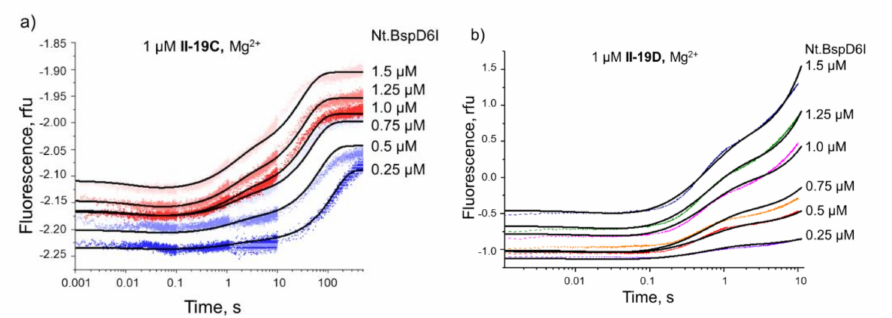
Figure 10. Kinetic curves describing the interaction of Nt.BspD6I (concentration is indicated on the right) in the presence of 10 mM MgCl 2 either ( a ) with 1 µ M duplex II-19C or ( b ) with 1 µ M duplex II-19D . Coloured dots and lines indicate experimental data, and black curves denote calculated kinetic curves conforming to Scheme